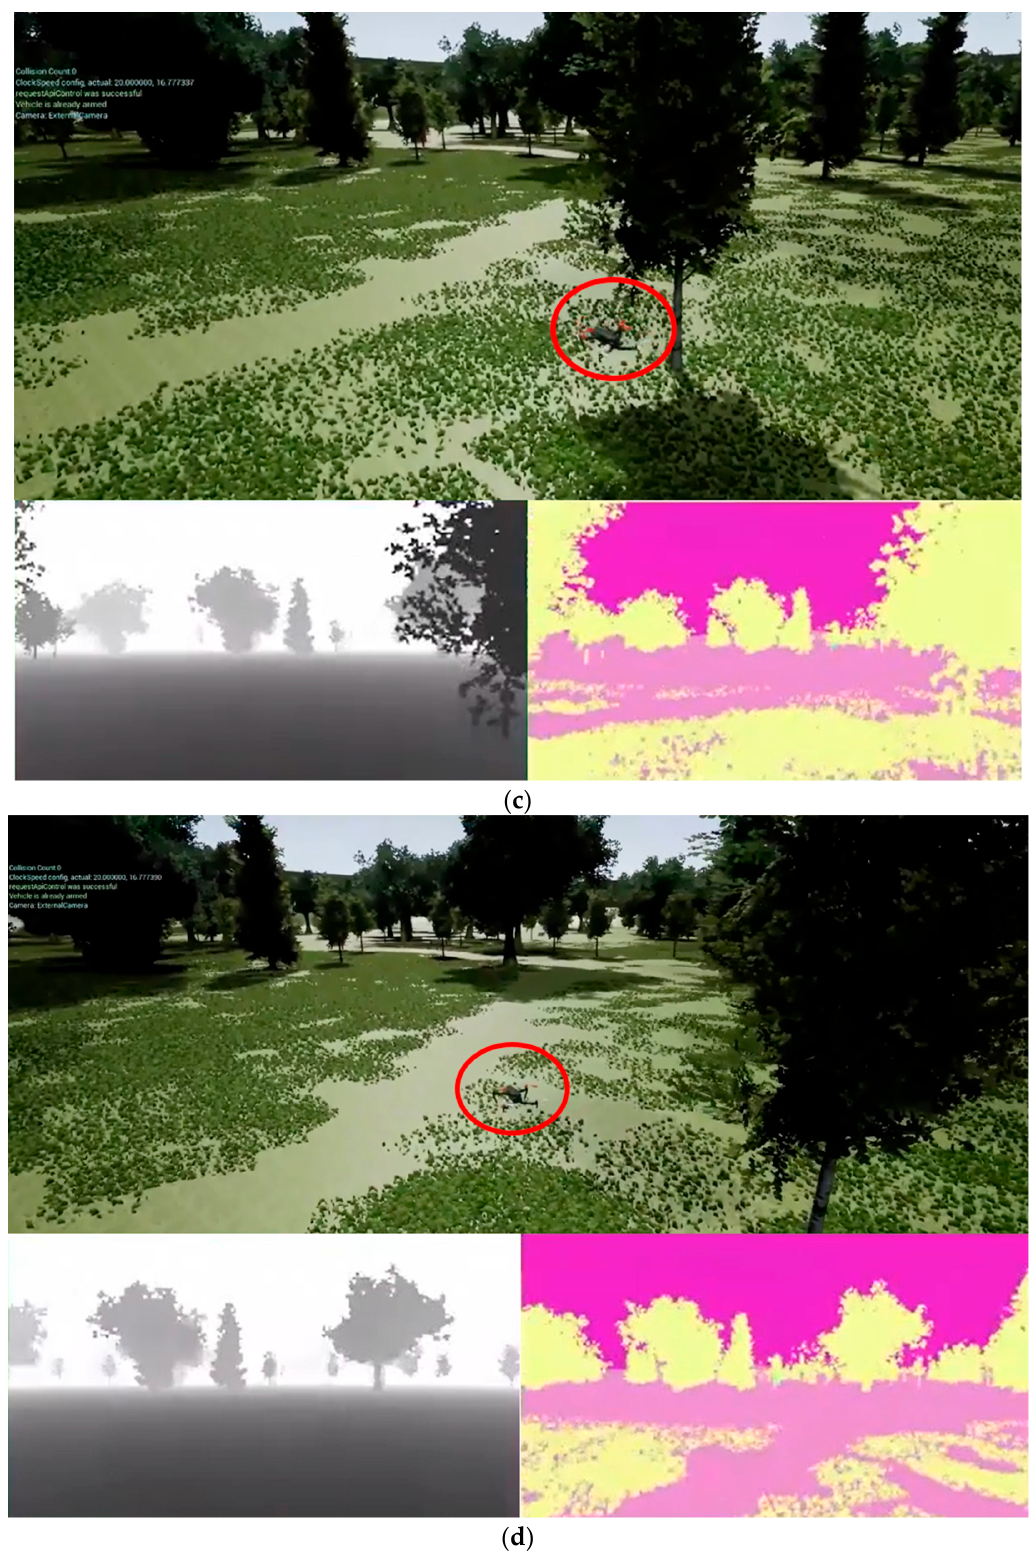
Figure 39. The experiment for testing obstacle avoidance in the simulation environment (part 1), ( a ) is the starting point, ( b ) shows the drone changes direction, ( c ) shows the tree is now on the right-hand side of the drone, ( d ) shows the UAV completely bypassed the obstacle.